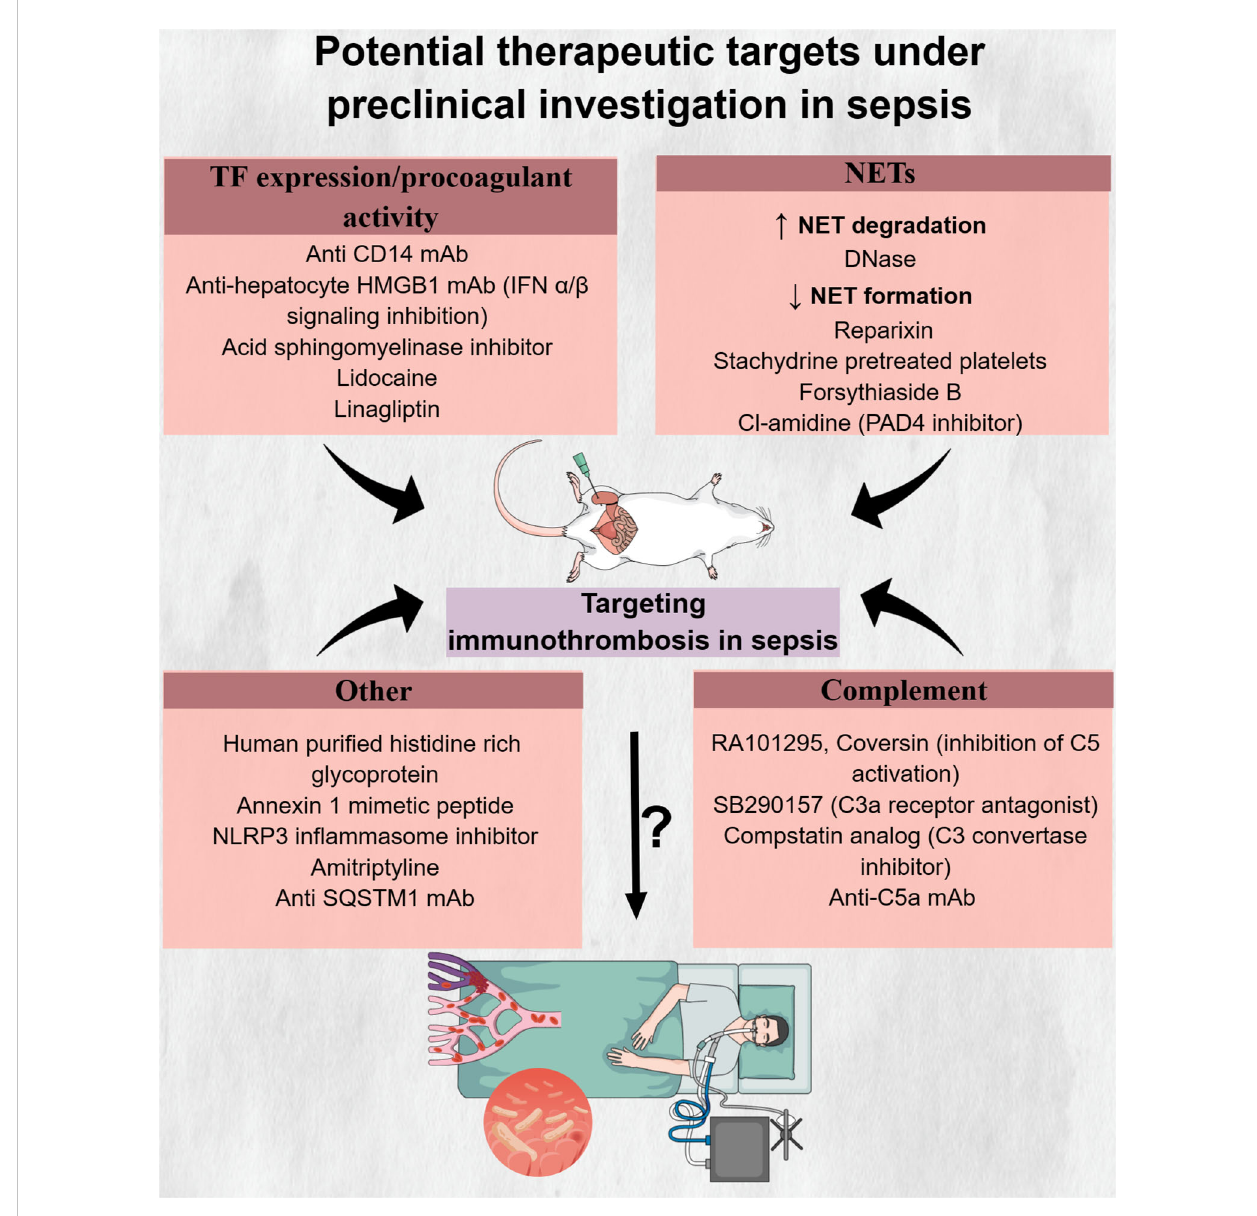
FIGURE 4 Potential therapeutic targets under preclinical investigation in sepsis. Inhibitors of innate immune components, like neutrophil extracellular traps and complement components C5 and C3, drugs interfering with tissue factor formation and procoagulant activity as well as molecules with multiple actions, have shown promising results in reducing immunothrombosis in preclinical sepsis models. However, the safety, tolerability, and effectiveness of these drugs in abrogating the deleterious effects of immunothrombosis in patients with sepsis are still unknown. C5, complement 5; C3, complement 3; CD14, cluster of differentiation 14; DNase, deoxyribonuclease; HMGB1, high mobility group box 1; IFN, interferon; mAb, monocloncal antibody; NETs, neutrophil extracellular traps; NLRP3, NLR family pyrin domain containing 3; PAD4, protein arginine deiminase; SQSTM1, sequestosome 1; TF, tissue